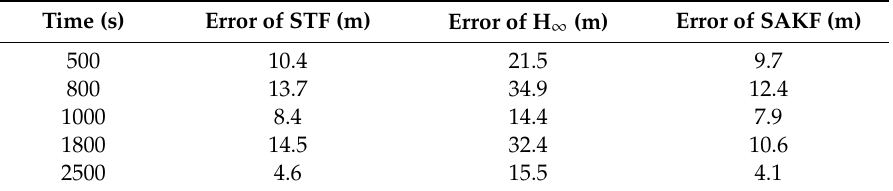
Table 5. Comparison of filtering